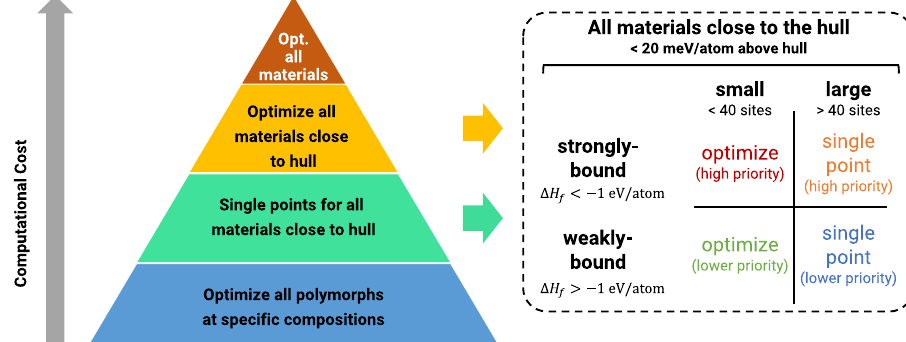
Fig. 3 Strategies for prioritizing higher level calculations in large materials databases. Left different stages of calculation coverage. The fi rst level enables application of Mixing Rule #1, while the second and third levels facilitate application of Rule #2. The fourth level (re- optimizing all materials with higher-level calculations) is not necessary. Right methods used by the Materials Project to pursue second- and third-level coverage of r 2 SCAN calculations. Optimizations of small, strongly-bound materials have the highest priority. single point calculations are used for large structures. Weakly-bound materials have lower priority. See Section “ Prioritizing r 2 SCAN calculations for maximum bene fi t ” for further